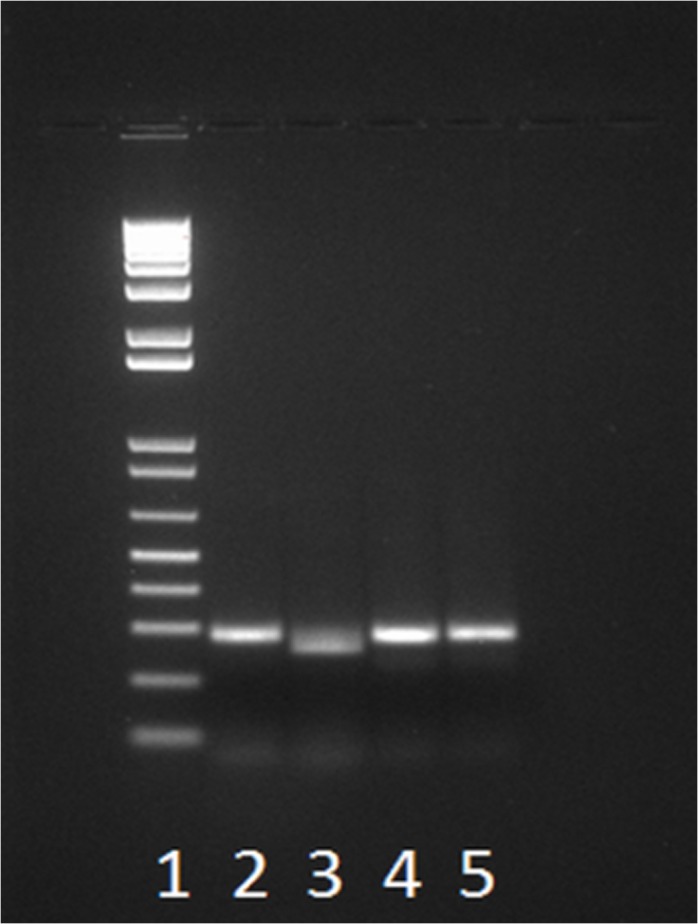
PCR amplification detecting the SNP difference between semi-dwarf and tall lines in a doubled haploid population segregating for the uzu locus.Lane 1: marker ladder; Lane 2: semi-dwarf (uzu), undigested; Lane 3: semi-dwarf (uzu), digested with HhaI; Lane 4: tall lines, undigested; Lane 5: tall lines, digested with HhaI.